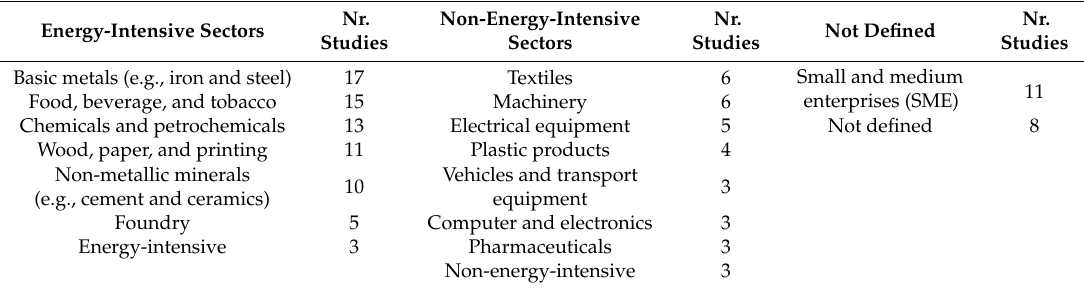
Table 3. Distribution of empirical studies by manufacturing sector.